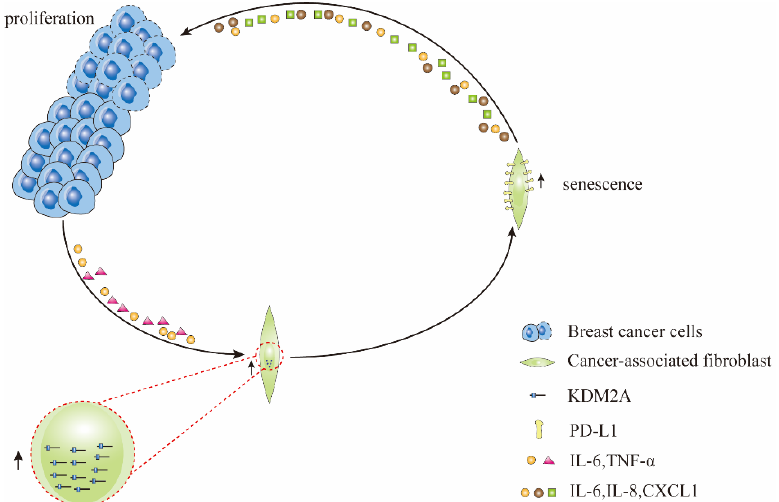
Figure 2. Cytokines, such as interleukin (IL)-6 and tumor necrosis factor-alpha (TNF- α), secreted by breast cancer cells, can stimulate the expression of KDM2A in cancer-associated fibroblasts, which induces the senescence of cancer-associated fibroblasts and upregulates the expression of programmed death-ligand 1 (PD-L1). PD-L1 and cytokines such as IL-6, IL-8, and C-X-C motif chemokine ligand 1 (CXCL1) secreted by senescent cancer-associated fibroblasts can promote the growth and proliferation of tumor cells.